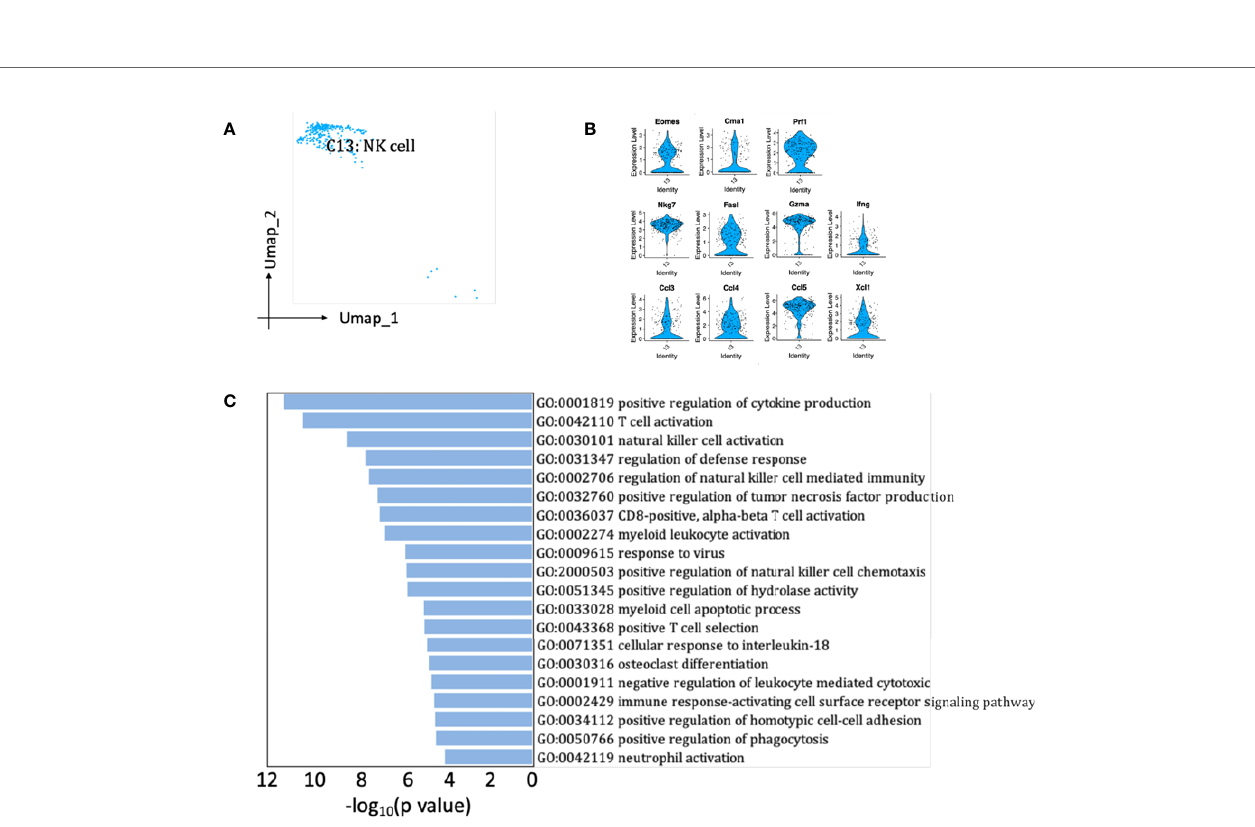
FIGURE 8 | NK cells presented in the allografted kidneys. (A) Integrated UMAP projection of the NK cell cluster identi fi ed in the kidney grafts (clusters 13), colored according to cluster designation. Cell identity is annotated on the cluster. (B) Violin plot showing normalized expression levels of markers in NK cell cluster. (C) Pathway enrichment of genes with avg_log 2 FC ≥ 0.59 in NK cell cluster. UMAP, Uniform Manifold Approximation and Projection; avg_log 2 FC, average log 2 fold change.